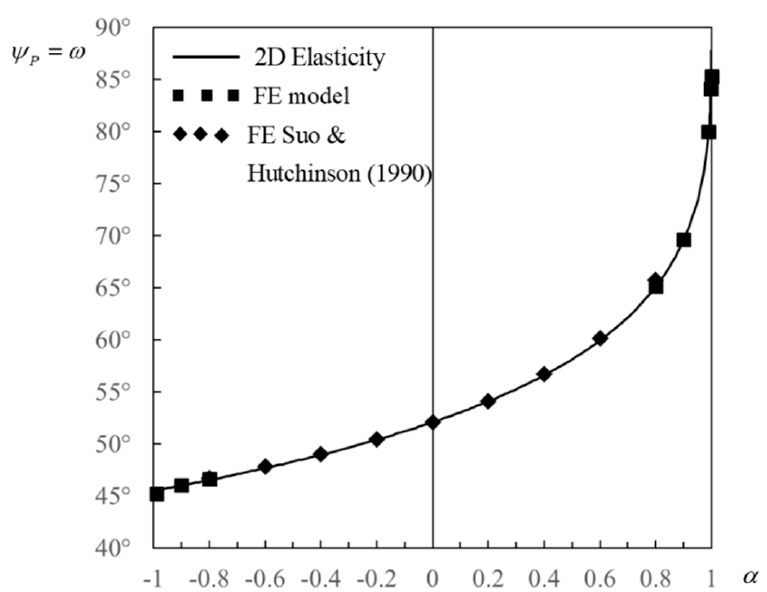
Figure 2. The mode-mixity phase angle ψ P = ω in the edge-delamination crack in Figure 1 with P (cid:54) = 0, M = V = 0, materials with β = 0. See also Figure 4 for results plotted on a logarithmic scale.